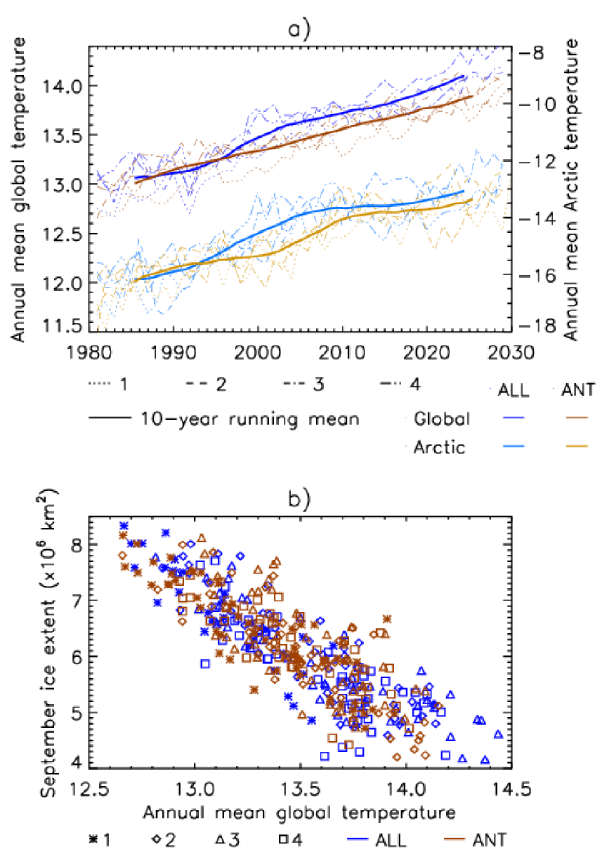
Fig. 3. (a) shows time series of global and Arctic temperature (mean temperature north of 70 ◦ N) in the ALL and ANT ensem- bles; (b) shows annual mean global temperature ( ◦ C) plotted against September mean ice extent ( × 106km 2 ).